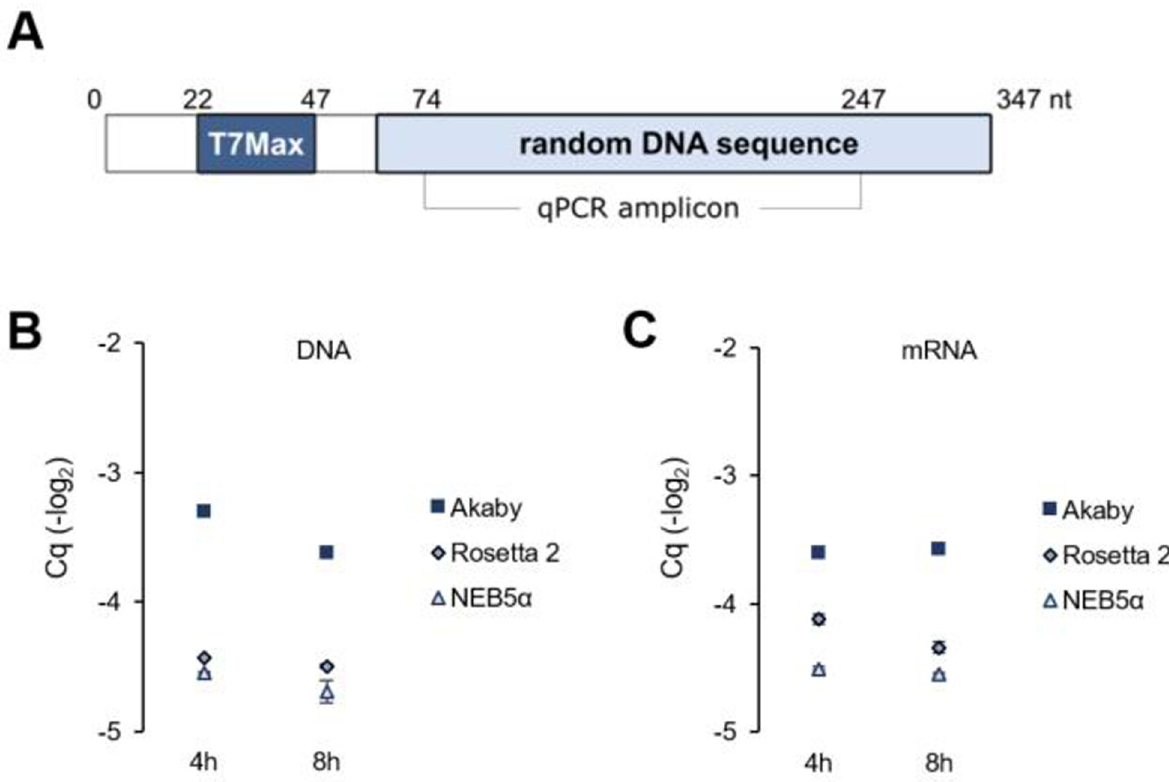
Fig 4. Short DNA stabilities and the abundance of its mRNA in Akaby, Rosetta 2, and NEB5 α TXTL at 4 and 8 hours incubation. (A) The design of a 347 nt length DNA fragment. The fragment consists a T7Max promoter and a random DNA sequence. The amplicon for qPCR is as described. (B) The DNA oligo (5 nM) was incubated in Akaby, Rosetta 2, or NEB5 α TXTL at 30˚C for 8 hours. After the incubation, DNA was purified with a DNA miniprep kit and qPCR experiments were conducted. (C) The abundances of mRNA in TXTL after 4 and 8 hours incubation were measured by RT-qPCR. T7Max, the enhanced T7 RNA polymerase promoter; Cq, quantitation cycle. The graphs show means with error bars that signify SEM (n = 3).